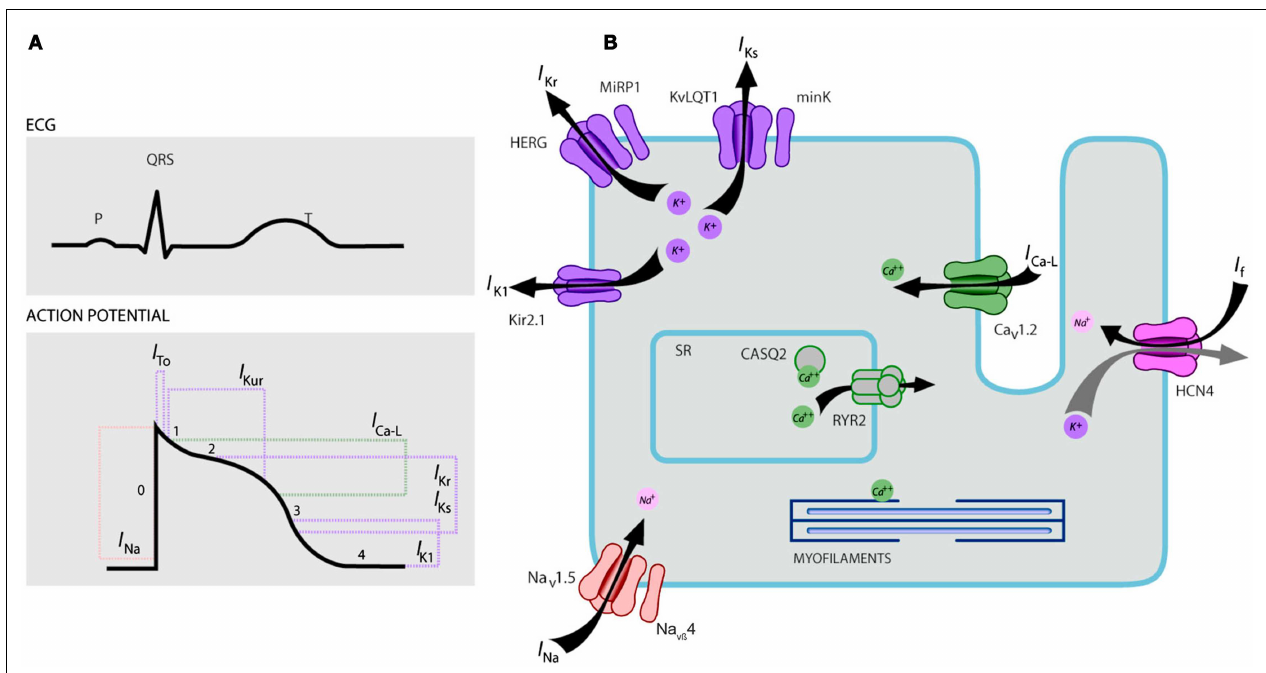
FIGURE 1 | Ionic currents contributing to the ventricular action potential (A) and schematic representation of a cardiomyocyte displaying (only) those proteins involved in the pathogenesis of inherited arrhythmia